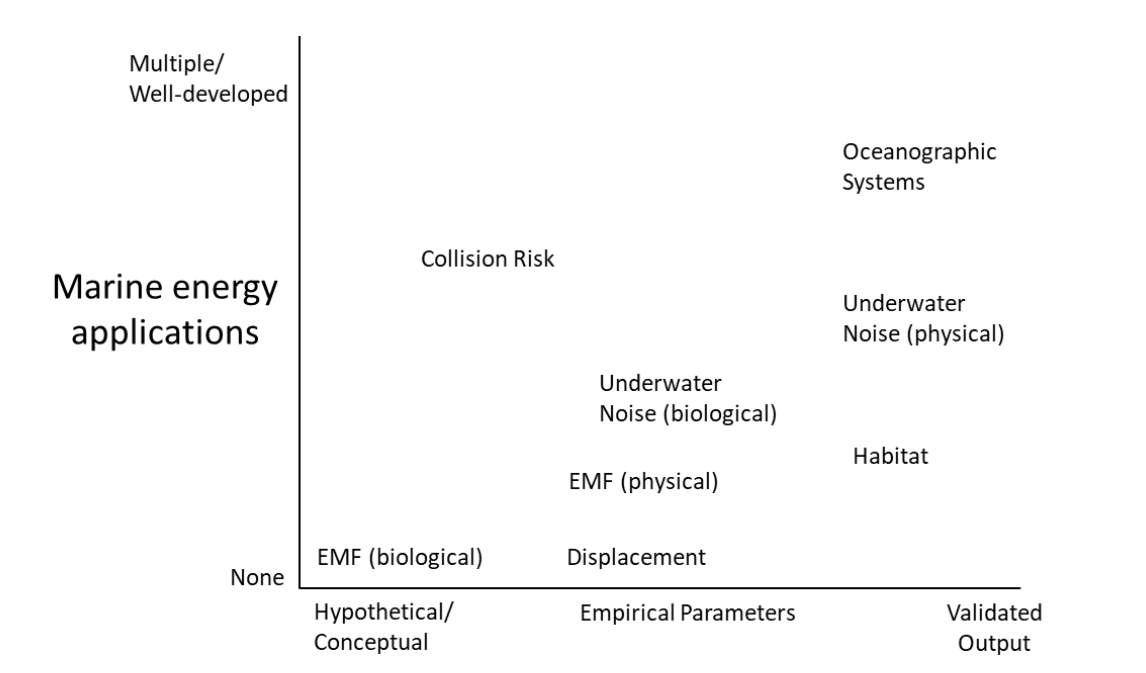
Figure 1. Relative maturity and availability of models for marine energy (ME) stressor-receptor interactions, including the availability of model approaches from other contexts that can be adapted for ME. The level of maturity and validation of modeling methods (for ME or analogous applications) ranges from hypothetical or conceptual (no empirical data) to field-validated real-world applications; ME-specific examples range from none to multiple and/or well-developed model approaches and published examples. EMF = electromagnetic fields.